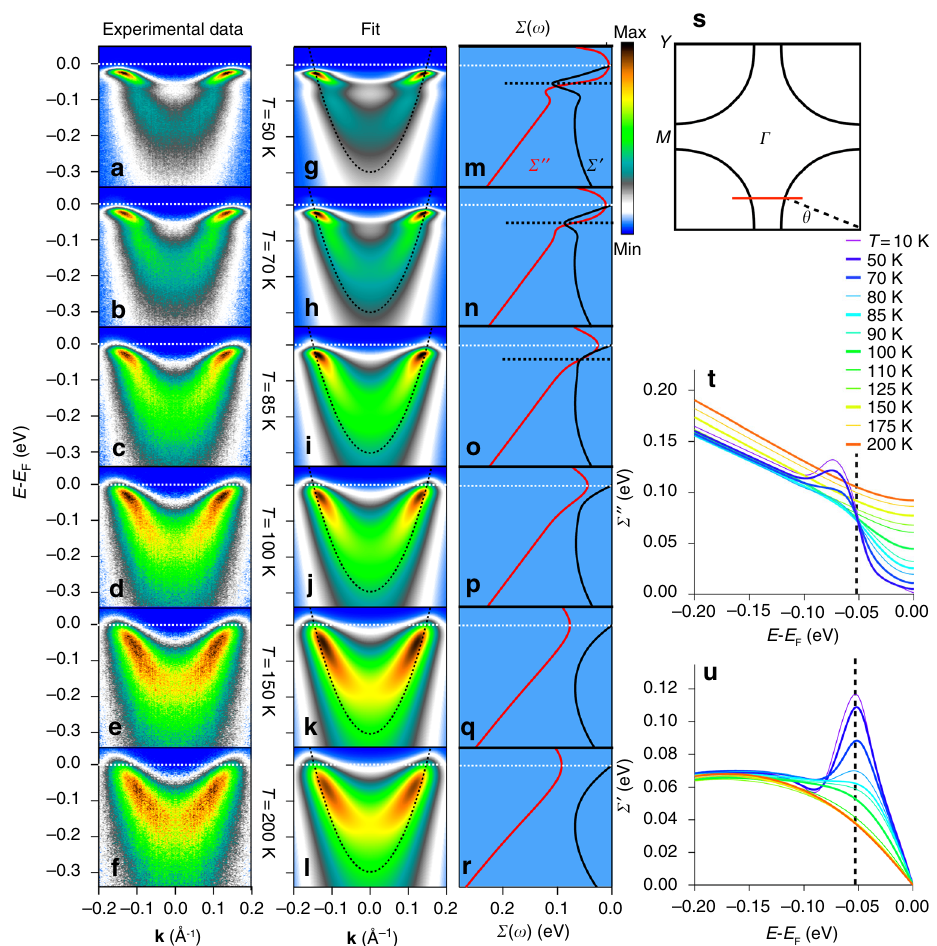
Fig. 1 Temperature-dependent ARPES spectra and self-energies. a – f Measured spectra from a mid-zone cut ( s ) of the antibonding band at multiple temperatures. g – l 2D fi ts to the corresponding ARPES spectra, with the main unknown parameters the superconducting gaps, the electronic self-energies and the bare electron band, where the dotted curve is the bare-band dispersion from the fi tting. m – r Correspondent self-energies extracted from the fi t spectra on the left. t Imaginary part of the self-energy Σ ″ (or scattering rate) vs. frequency and temperature obtained from the 2D fi ts. There is a strong reduction or gapping of the near E F scattering rate as temperature is lowered into the paired state, along with a shift of this scattering to high energies beyond the dashed line. Along with this is a strong kink or mass enhancement in the real part of self-energy Σ ′ ( u) . These effects of Σ ″ and Σ ′ are responsible for the dramatic fl attening and sharpening of the low-energy states of a – f , g – l . All data were taken with 9 eV photons, and the Fermi surface angle was θ = 22.5